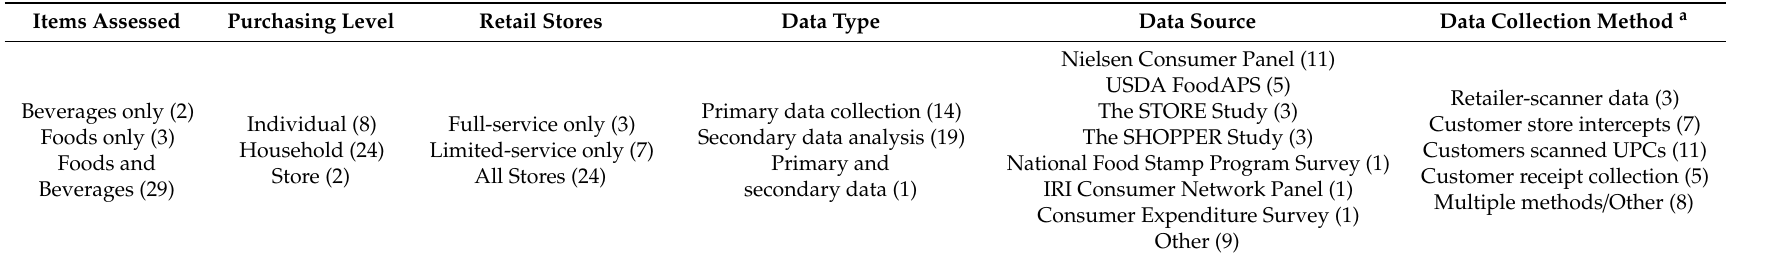
Table 1. Summary of Customer Purchasing Data Assessment Methodologies of Included Studies ( n = 34).